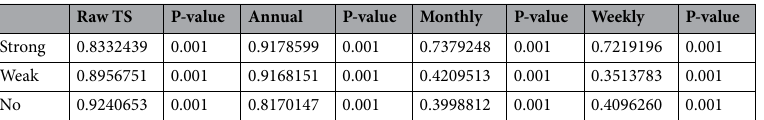
Table 2. Kendall’s coefficient of concordance ( W ) measuring the degree of synchrony between sites within a specified upwelling condition. This statistic was measured across sites for the raw time series as well as for scale-averaged wavelet power at annual, monthly and weekly scales. Rows correspond to upwelling condition (strong, weak or no upwelling). Columns correspond to values computed for the raw time series and the resulting P -value, and scale averaged power at annual (300–400 days), monthly (15–45 days) and weekly (2–10 days) periodicities, respectively.